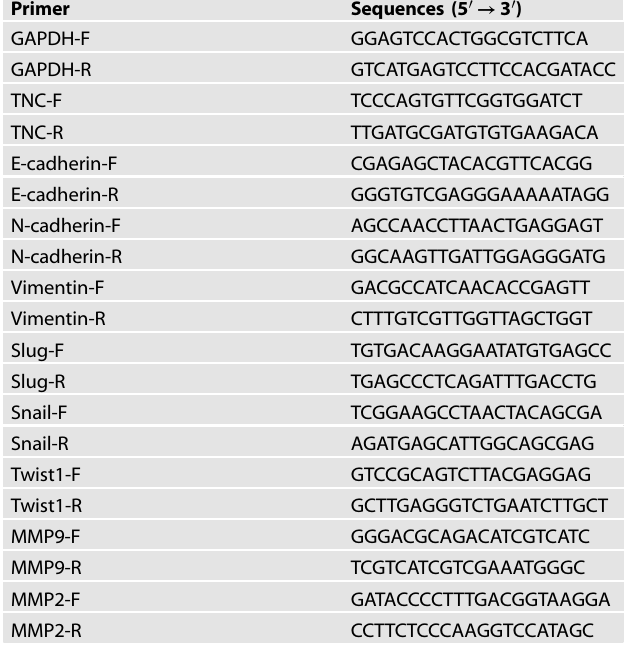
Table 1. Primer used in quantitative real-time PCR